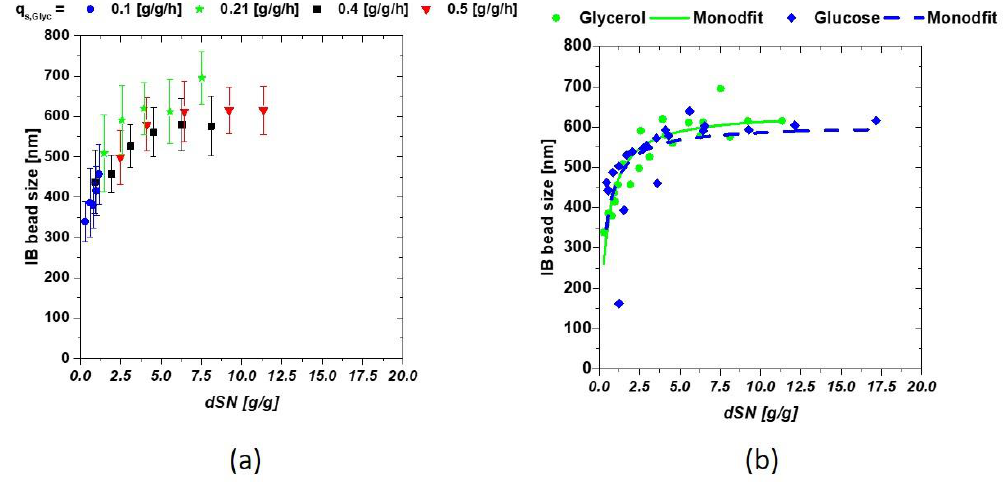
Figure 2. ( a ) IB-bead size dependencies on the amount of fed glycerol shown calculated as dSn value ( b ) dependence of the IB bead diameter when compared between glucose and glycerol.